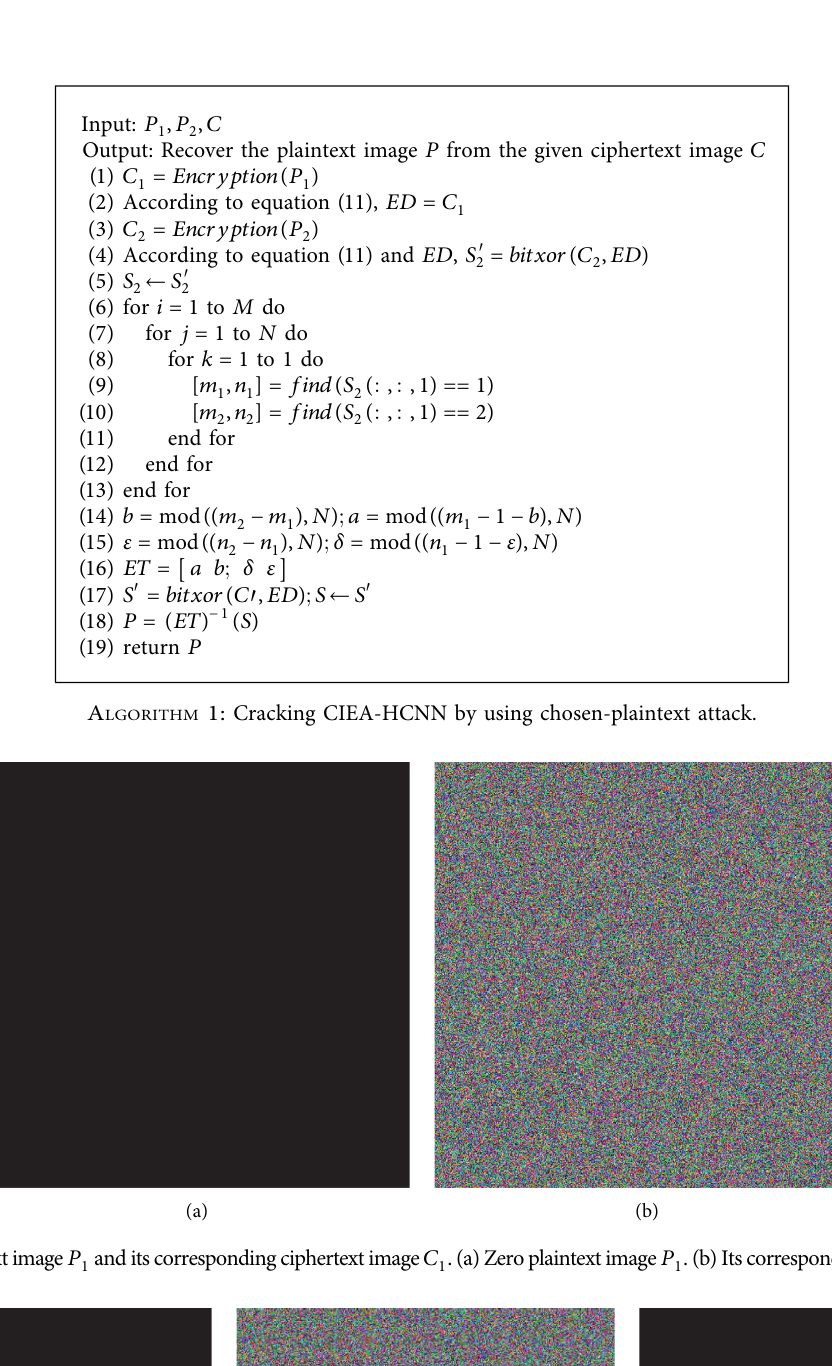
. (a)Zeroplaintextimage P 1